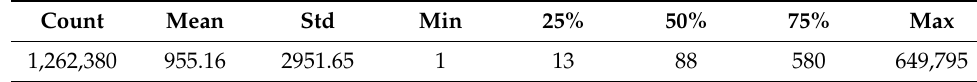
Table 5. Statistics of passenger flow dataset.